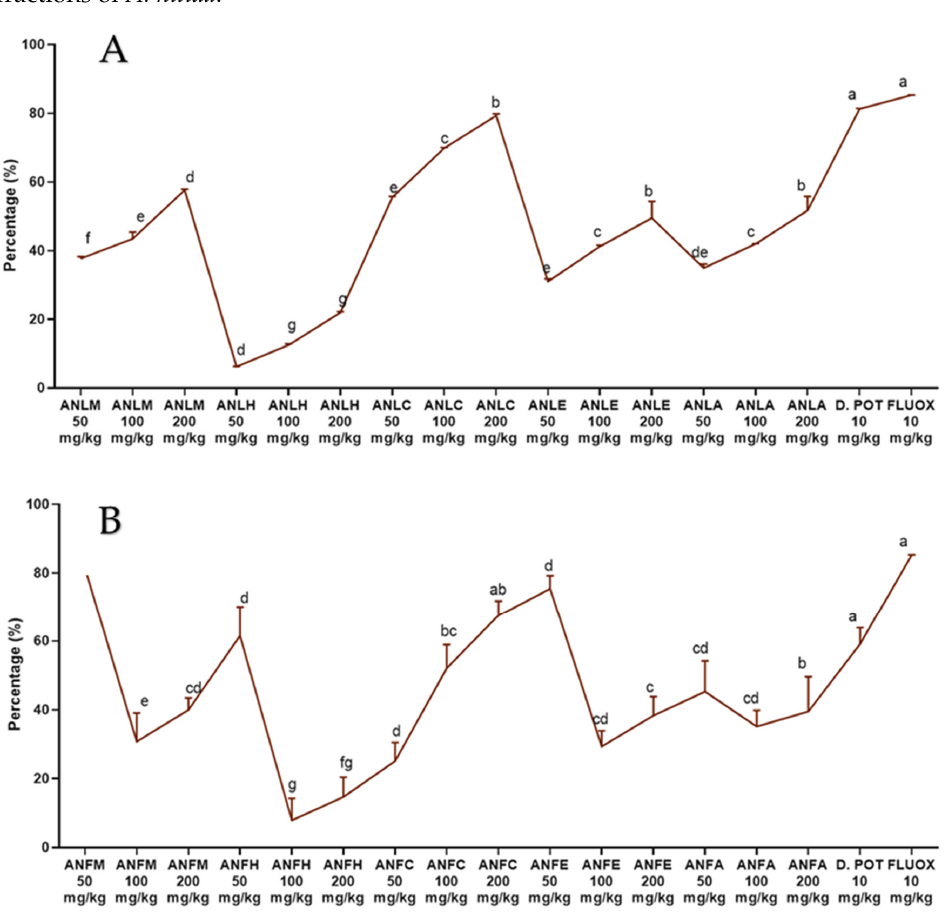
Figure 4. Percentage inhibition of A. nitida on xylene-induced ear edema in rats ( A ) A. nitida leaves methanolic extract (ANLM), A. nitida leaves n-hexane fraction (ANLH), A. nitida leaves chloroform fraction (ANLC), A. nitida leaves ethyl acetate fraction (ANLE), A. nitida leaves aqueous fraction (ANLA) and ( B ) A. nitida fruit methanolic extract (ANFM), A. nitida fruit n-hexane fraction (ANFH), A. nitida fruit chloroform fraction (ANFC), A. nitida fruit ethyl acetate fraction (ANFE), A. nitida fruit aqueous fraction (ANFA). D.POT: Diclofenac potassium; FLUOX: Fluoxetine. Data were analyzed using seven replicates as mean ± SD by one way ANOVA followed by Tukey’s test. Different letters represent the significance level of p < 0.05 with respect to all other samples “a, b” with reference to positive controls, “c” with reference to methanolic extract and “d, e, f, g” with reference to n-hexane, chloroform, ethyl acetate and aqueous fraction,